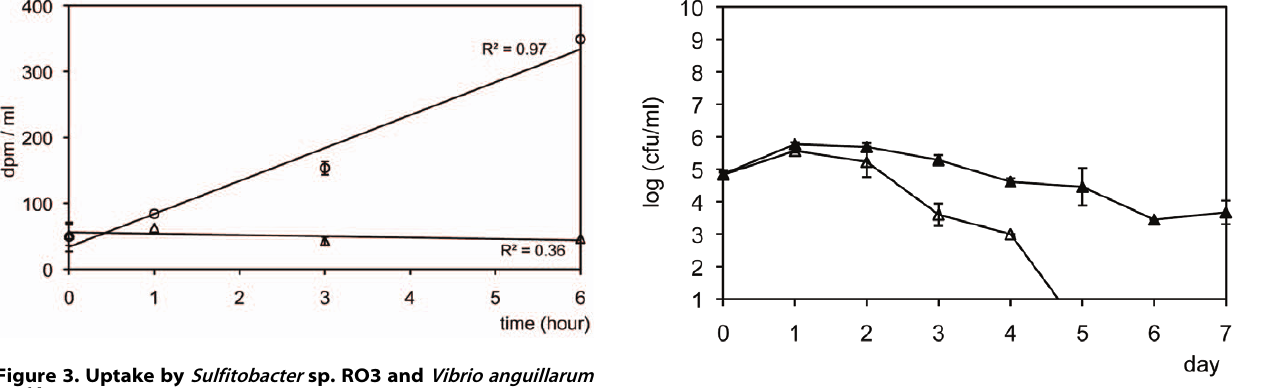
Figure 4. Cell densities of V. anguillarum in autoclaved NCF medium. Closed triangles: V. anguillarum only (control), and open triangles: V. anguillarum in the mix culture of Sulfitobacter sp. (Error